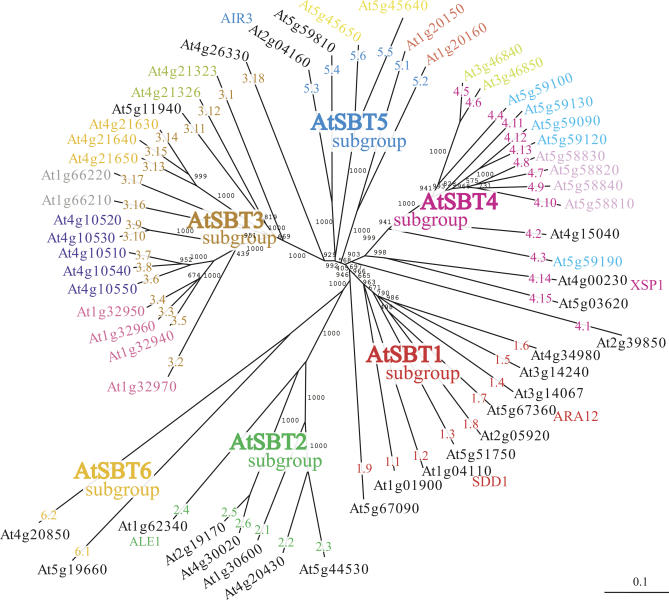
Bootstrapped Neighbour-Joining Tree Generated from an Alignment of the Predicted 56 AtSBT Full-Length Protein SequencesGroups of neighbouring genes (e.g., At3g46840 and At3g46850) are distinguished by specific colours.